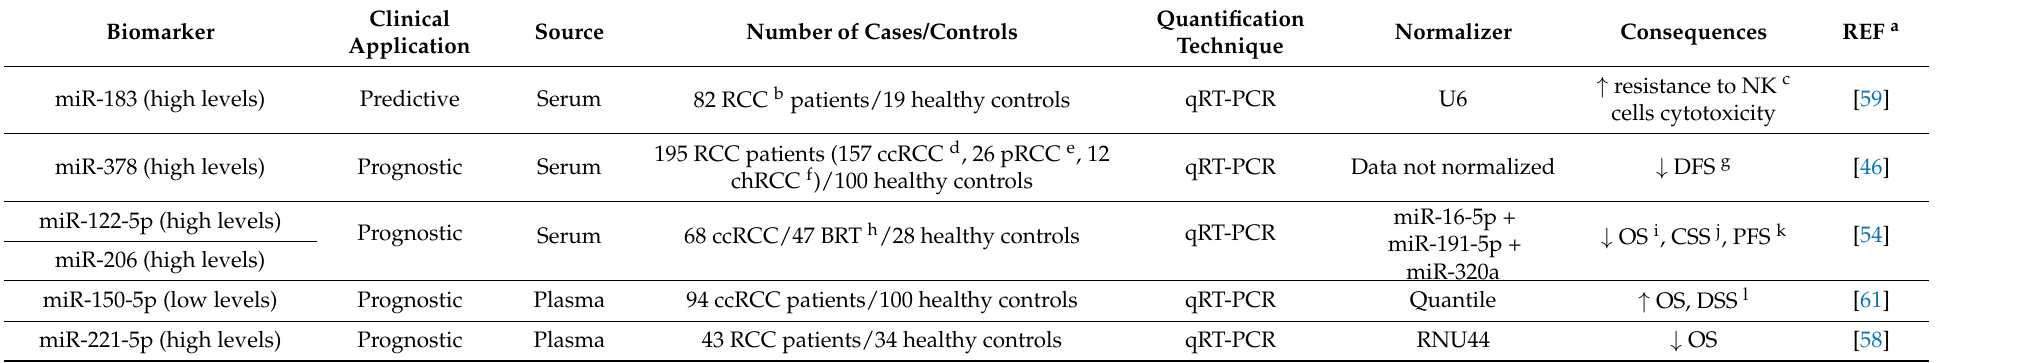
Table 2. Promising predictive and prognostic circulating miRNA in renal cell carcinoma